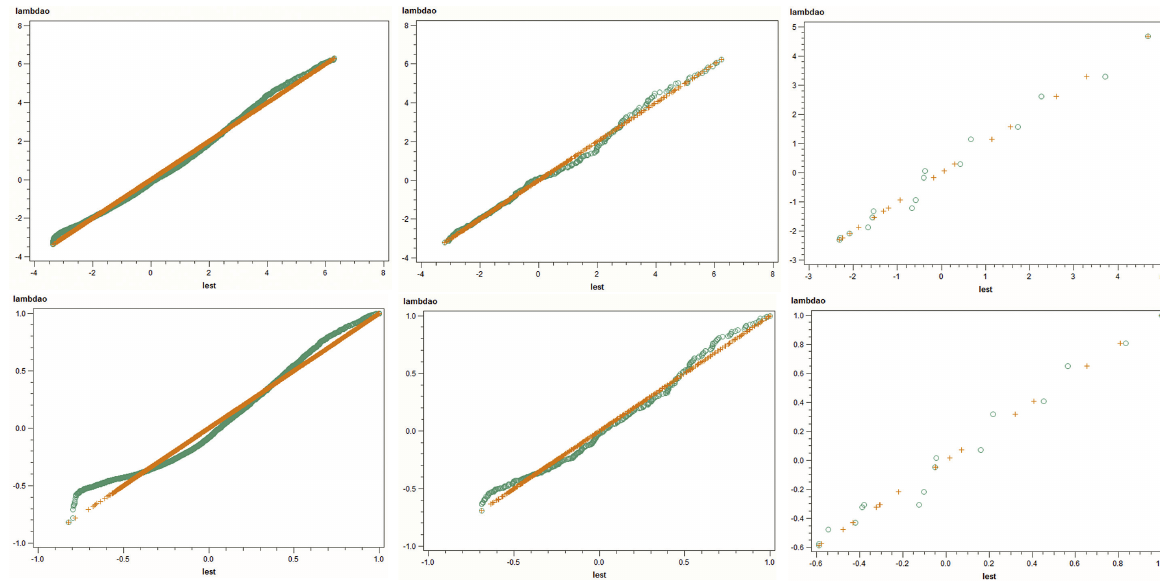
Fig. 10. Scatterplots of approximation versus actual eigenvalues for the surface partitioning of Poland Top row: matrix C . Bottom row: matrix W . Left-hand column: communes. Middle column: poviats. Right-hand column: